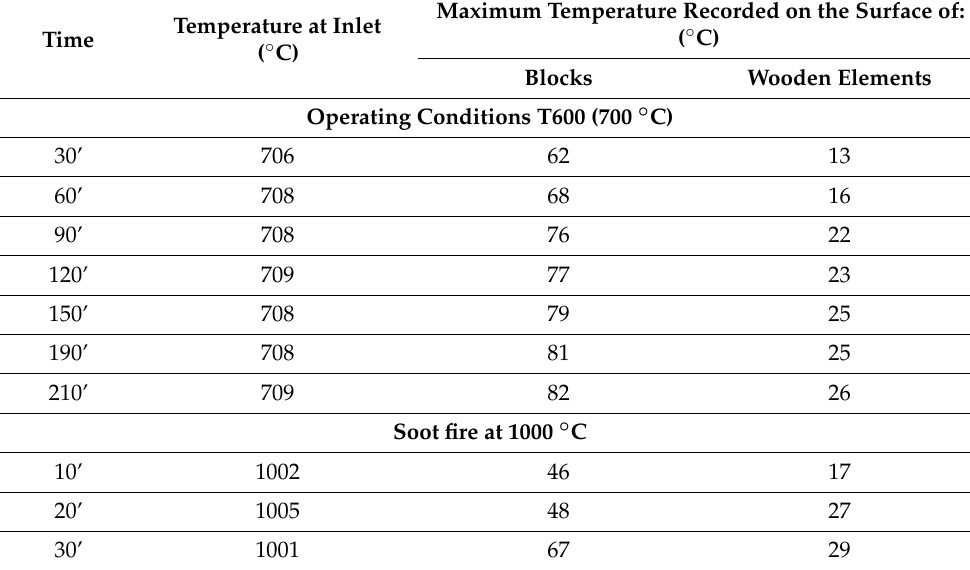
Table 4. Results of fire tests in operating conditions T600 (700 ◦ C) and in soot fire conditions (1000 ◦